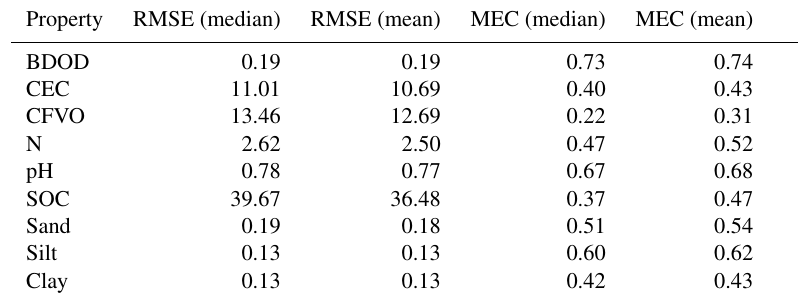
Table 4. Global cross-validation results for both mean and median predictions. See Table 1 for abbreviations and units of the soil properties considered.